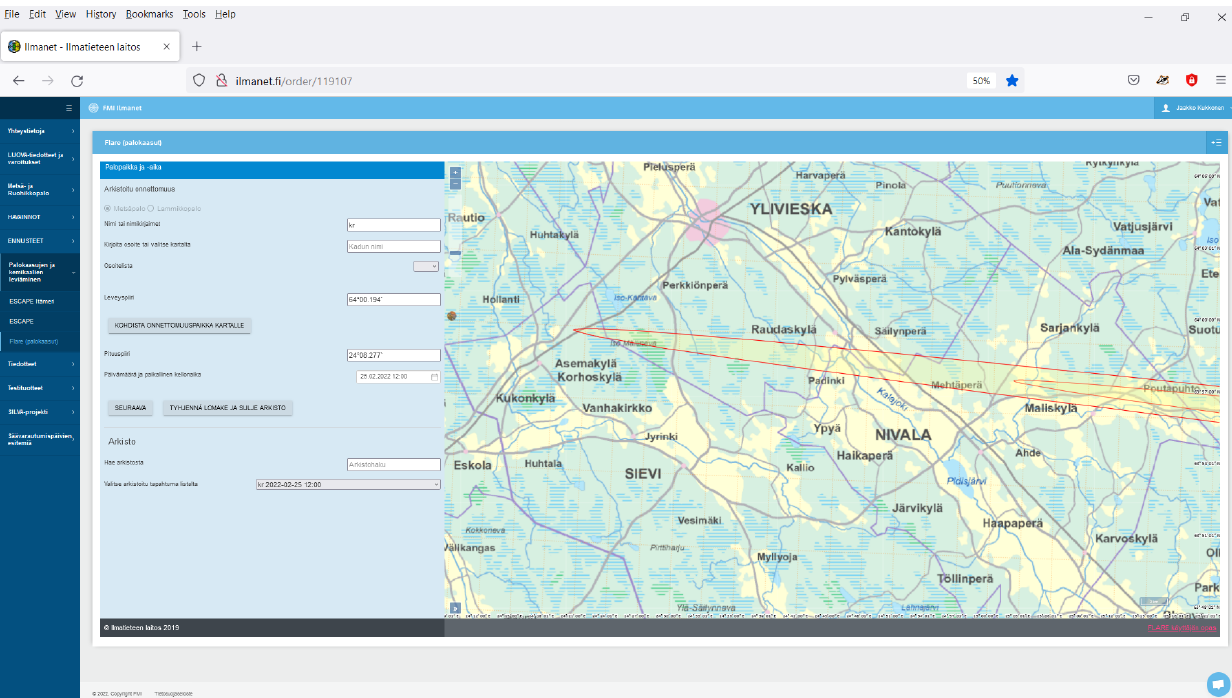
Figure D1. A screenshot of an application of the operational model version. The plume originated from a forest fire on 25 July 2021 in western Finland. On the right-hand side, the concentrations of CO 2 at the ground level are presented on a map. The physical scale of the figure is approximately 20km in the east–west direction. On the left-hand side, the model user has specified identification information for this case and has input the time and location of the fire on a map. The meteorological and forestry information has been automatically extracted for the